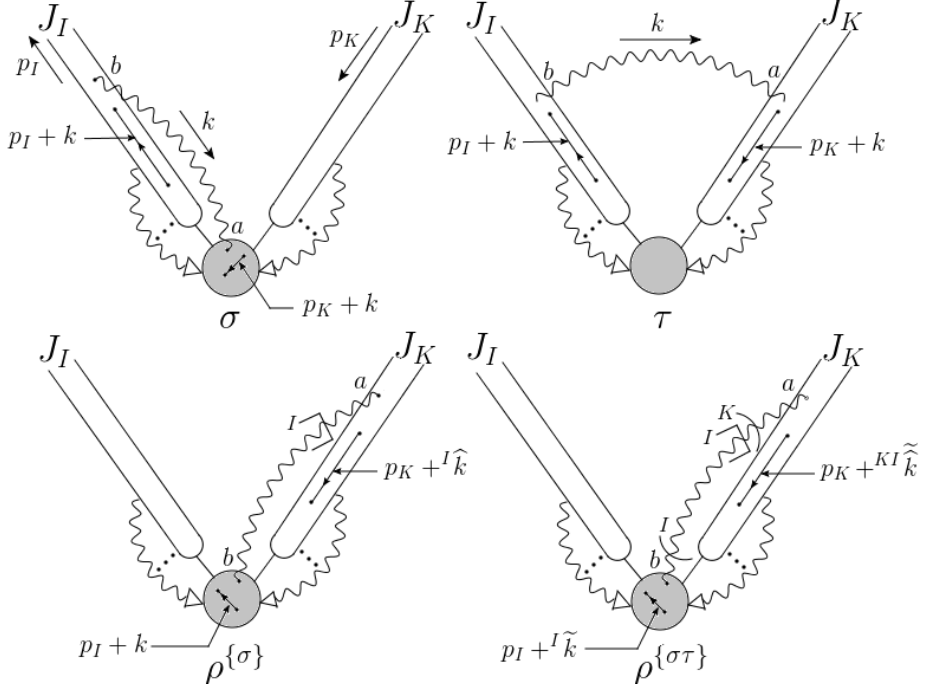
Figure 28. A pictorial illustration of pinch surfaces (cid:27) and (cid:28) of A , (cid:26) f (cid:27) g of t (cid:27) A and (cid:26) f (cid:27)(cid:28) g of t (cid:27) t (cid:28) A T J ( (cid:26) ) in case (II), where ab is an element of J ( (cid:27) ) (cid:26) S ( (cid:28) ) , whose endpoint a is in H ( (cid:27) ) T J ( (cid:26) ) , and I K K b is in H ( (cid:26) ) T J ( (cid:27) ) . The shaded areas represent the hard subgraphs in each region (and are not all I the same). Denote the momentum of ab as k (cid:22) . All the propagator momenta in A that contain k are of the forms p I + k and p K + k , where p I ( p K ) is the momentum of a propagator in J I ( J K ). In the approximated amplitude (cid:26) f (cid:27) g , p K + k becomes p K + I b k , while in (cid:26) f (cid:27)(cid:28) g , p I + k becomes p I + I e k and p K + k becomes p K + KI eb k